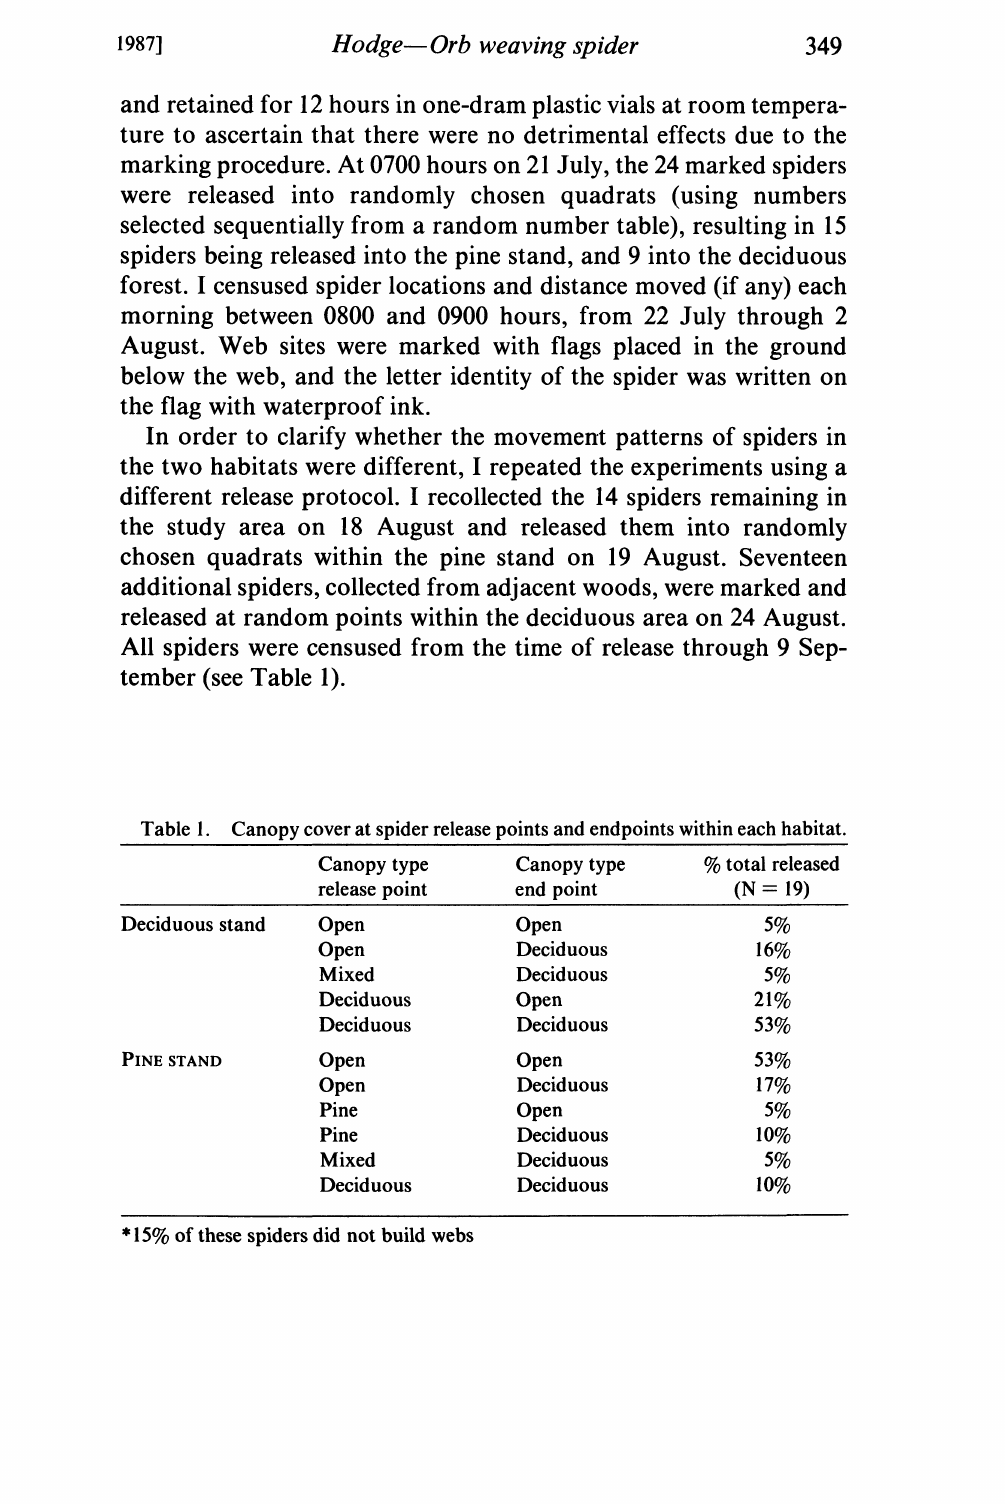
Table 1. Canopy cover at spider release points and endpoints within each